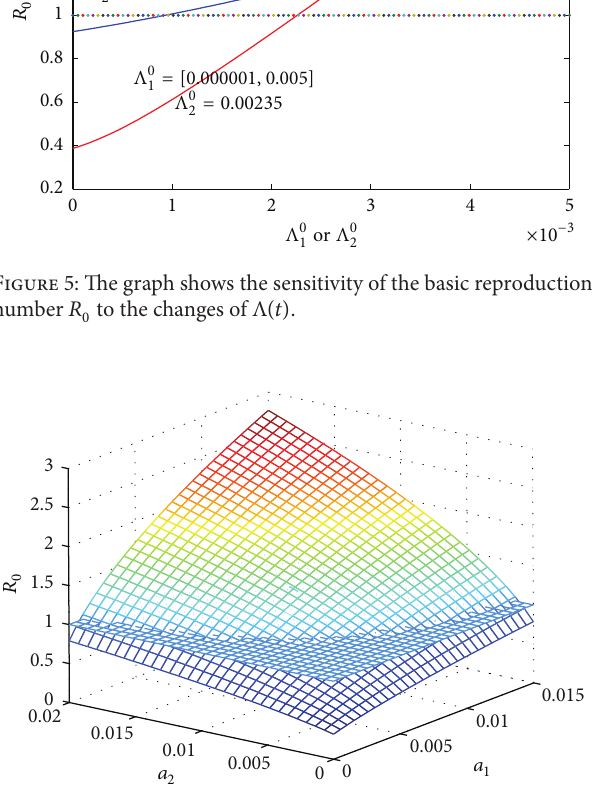
globally asymptotically stable and the disease dies out when < 1 . When 𝑅 > 1 , the disease persists. 𝑅 0 0